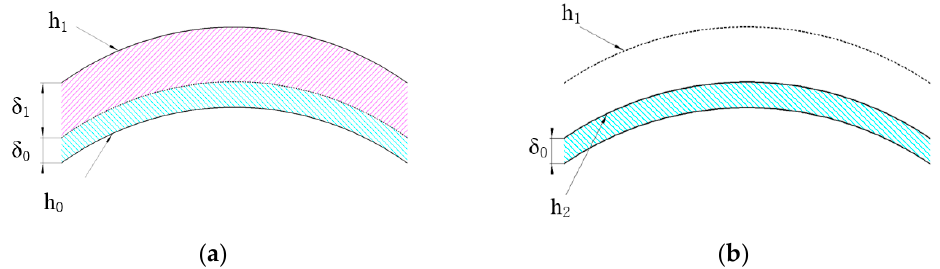
Figure 3. Changes in the mirror surface after clamping and removing. ( a ) The mirror surface after clamping and ( b ) the mirror surface after removing.